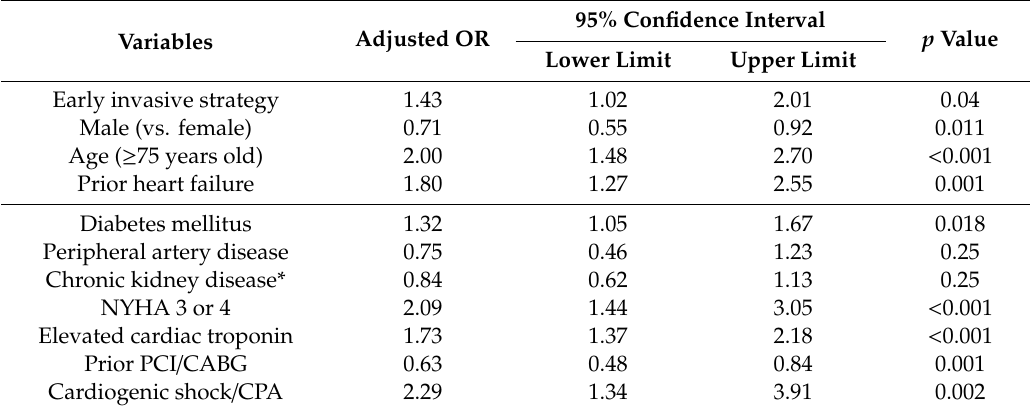
Table 3. Factors associated with development of acute kidney